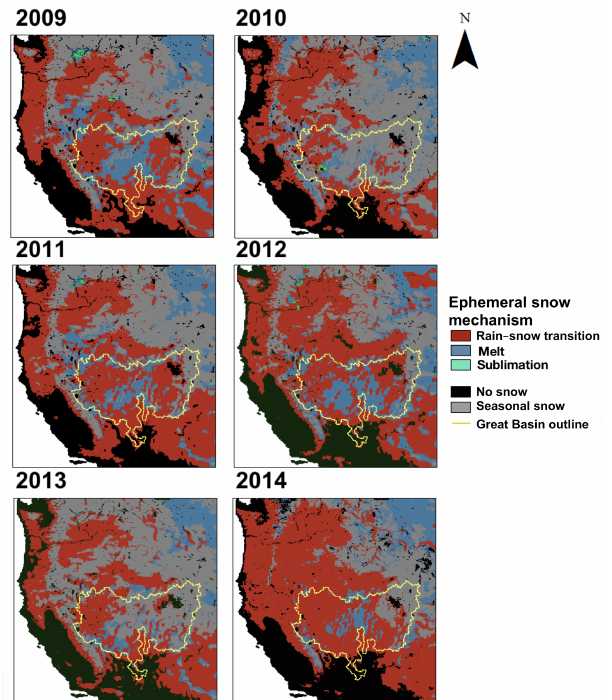
Figure 10. Dominant mechanisms for snow ephemerality from wa- ter years 2009–2014 in the western United States. Areas with sea- sonal snow (grey), no snow (black), and water bodies (black) are also depicted. The Great Basin region is outlined in yellow.